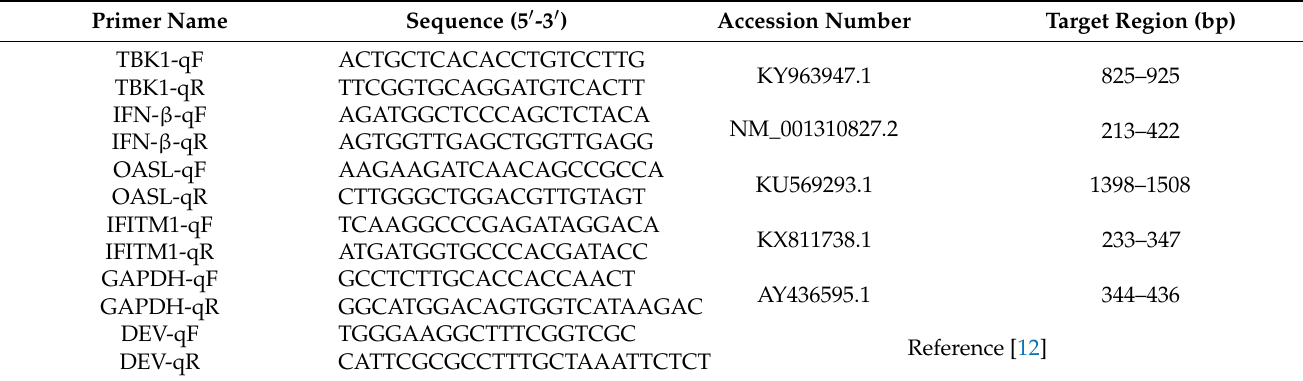
Table 3. Primer sequences used for